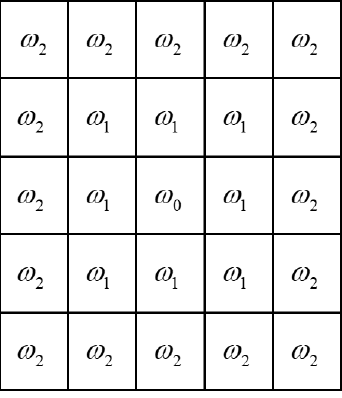
Figure 5. The 5 × 5 mask.